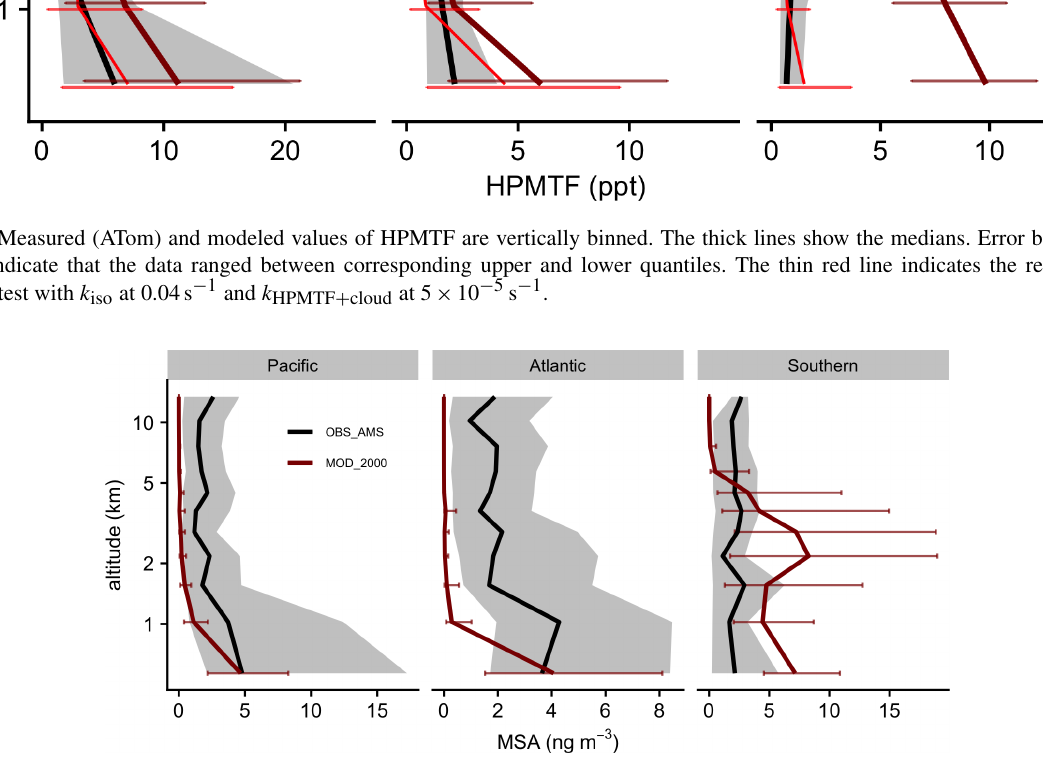
Figure 10. Medians of observed (ATom) and modeled concentration of MSA aerosol are vertically binned. The thick lines show the medians. Error bars and gray shadings indicate that the data ranged between the corresponding upper and lower